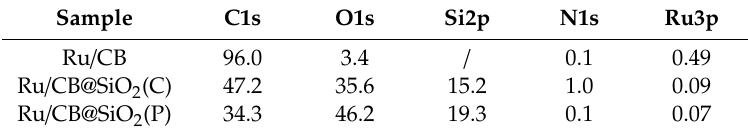
Table 1. X-ray photoelectron spectroscopy (XPS) analyses of reference and covered